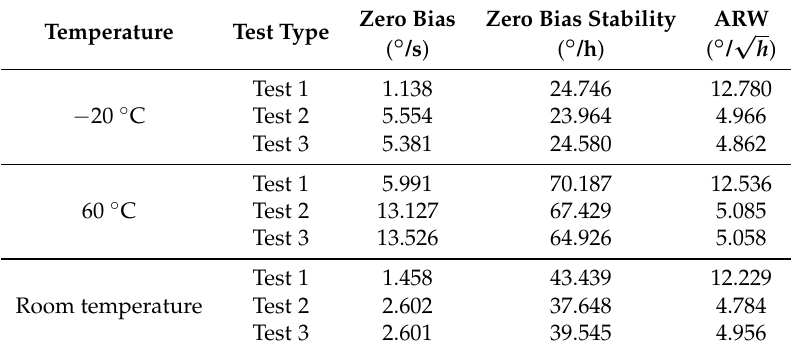
Table 3. Static performance of the three test methods at different